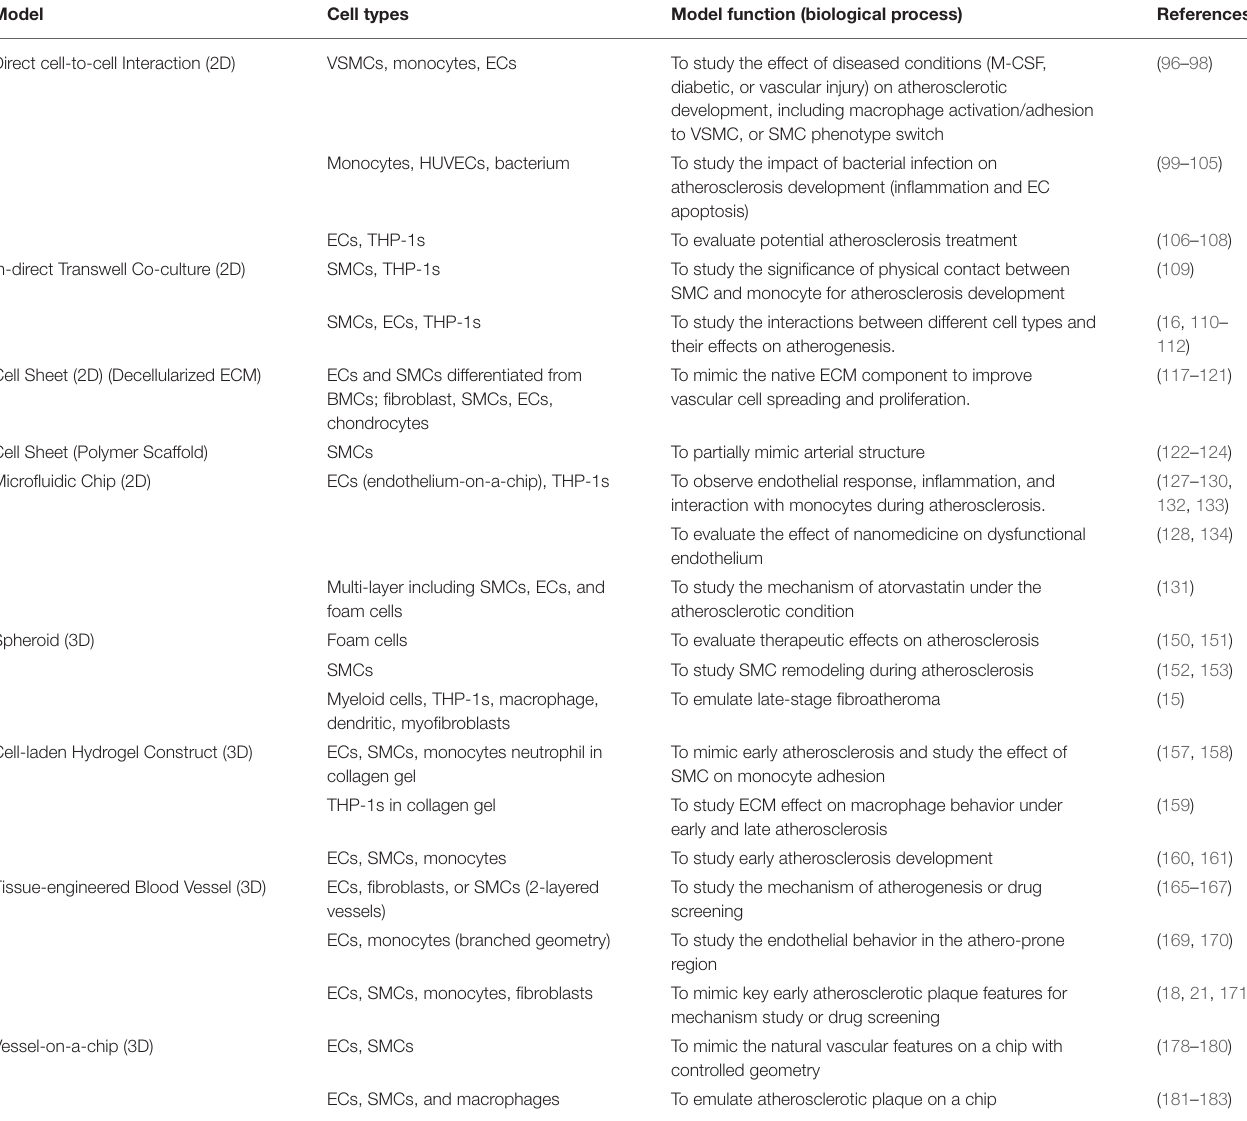
TABLE 3 | Summarization of the models, cell types, and biological processes studied using in vitro 2D culture systems and in vitro 3D systems covered in the current review.